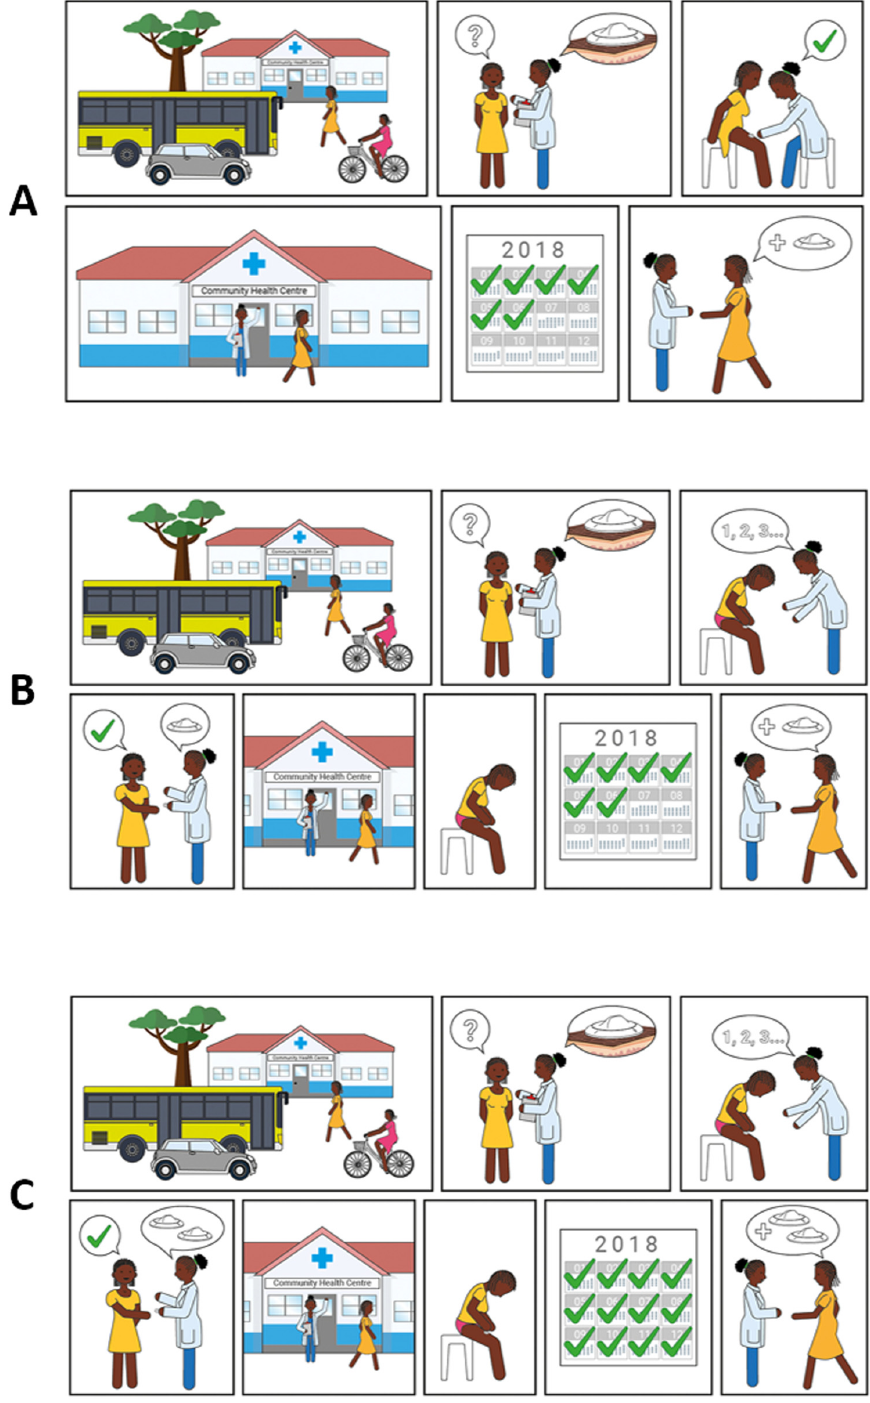
Figure 7. Illustrations used to present different access scenarios to participants. Scenario A ) Access is always via a health centre, where a health care professional applies the contraceptive. Scenario B ) Access is via a health centre, where a healthcare professional trains the user on how to apply the contraceptive correctly; self-applications are then performed when desired. Users must return to the health centre to receive subsequent contraceptives when needed. Scenario C ) Access is via a health centre, where a healthcare professional trains the user on how to apply the contraceptive correctly and gives them 2 devices. Users do not need to return to the health centre for a second application when the contraceptive effect of the first application lapses.